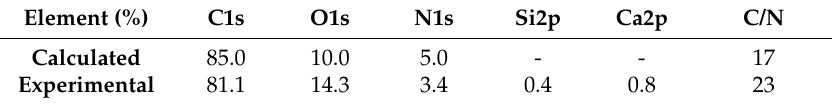
Table 1. Experimental and calculated XPS elemental analysis of HAPtS.